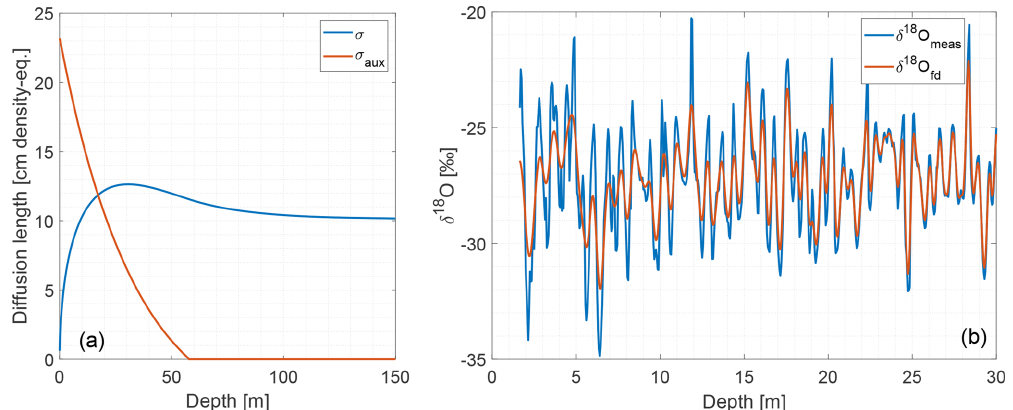
Figure C1. (a) Modeled firn diffusion with depth ( σ ; blue) and calculated auxiliary diffusion length that should be applied to the measured δ 18 O data ( σ aux ; red). After the pore close-off ( ρ pc = 804 . 3kgm − 3 ), σ aux = 0 as σ just changes due to the compaction of firn. (b) The measured δ 18 O data (blue) and the forward-diffused δ 18 O data (red) for the 1988 M core.